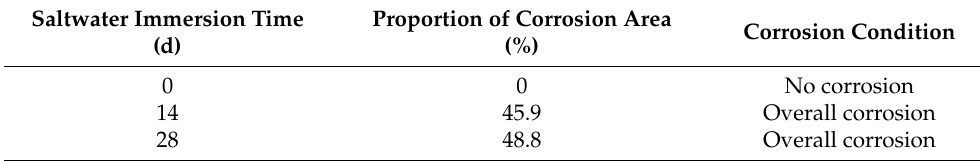
Figure 24. Corrosion of the no-zinc specimens after saltwater corrosion for ( a ) 0 days, ( b ) 14 days, the Chinese character “ 车 ” is the meaning of vehicle, and ( c ) 28 days (Note: the red area represents the corrosion area, and the value is the proportion of the corrosion area). Table 16. Influence of the saltwater corrosion time on the corrosion of the no-zinc steel plate speci- mens.